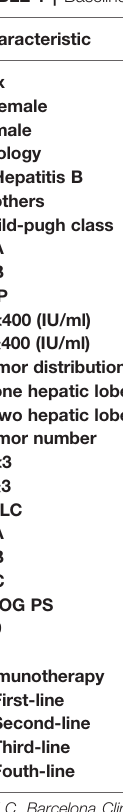
TABLE 1 | Baseline characteristics in 31 patients (mean age 57.5 y ±